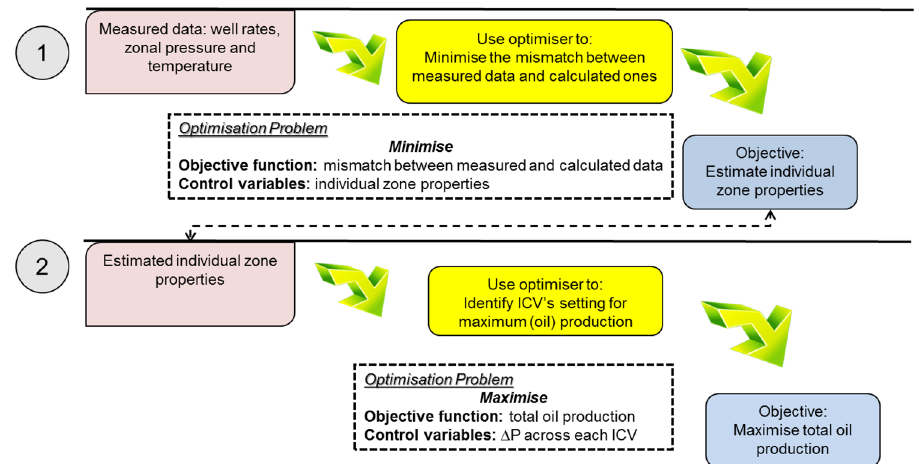
Fig. 4 Comparison between optimisation